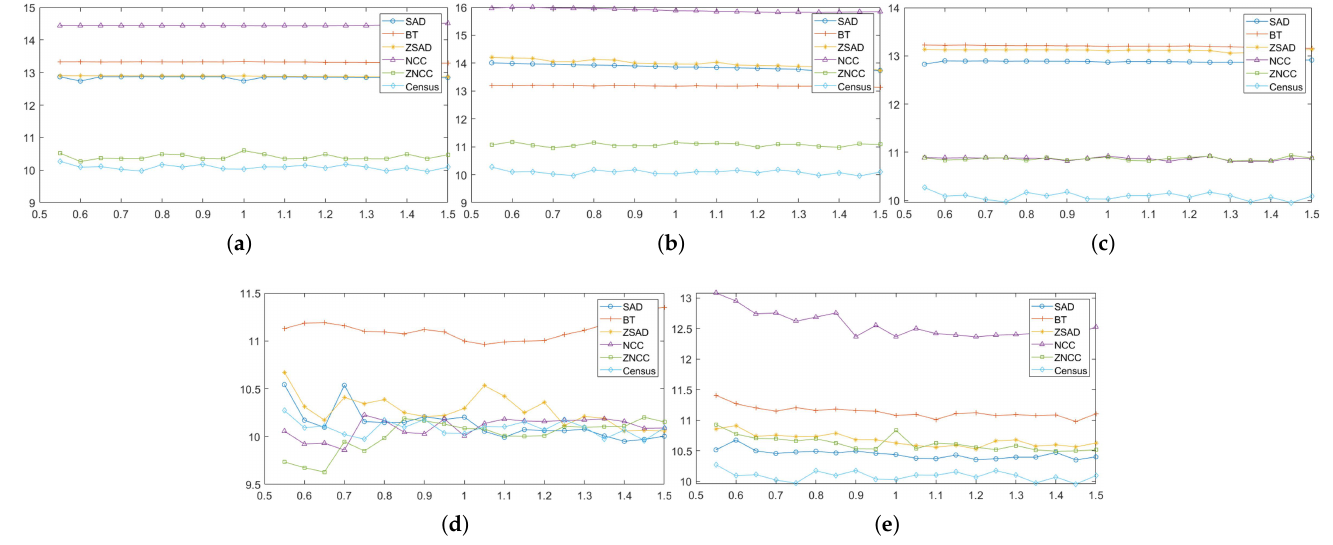
Figure 22. Errors of combinations of cost and image filter using the window-based stereo method, according to the variation of the image’s gain parameter. ( a ) Non-filter. ( b ) Mean. ( c ) LoG. ( d ) BilSub.